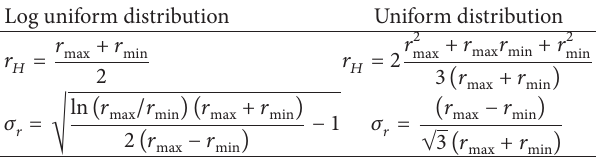
Table 3: Value of 𝑠 𝑟 , 𝑟